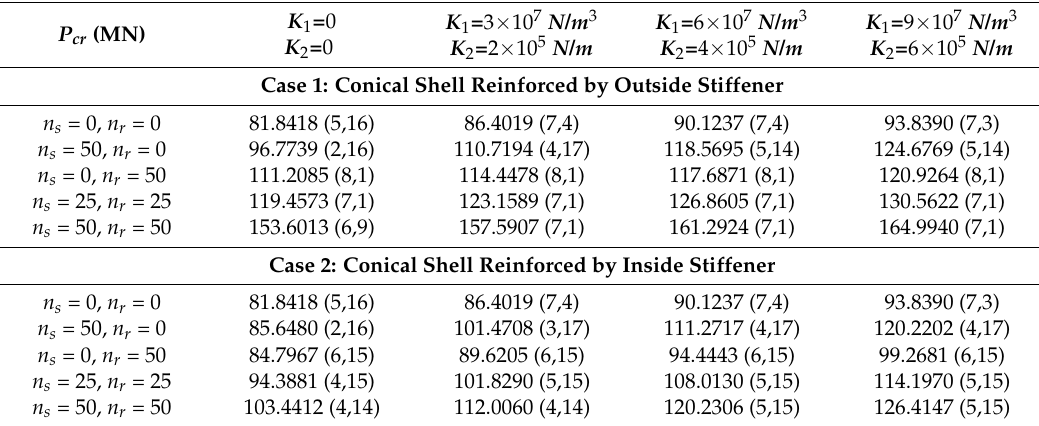
Table 9. Effects of stiffeners and foundation on buckling loads P cr